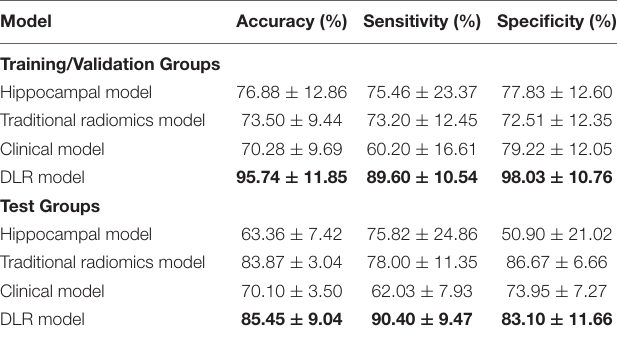
TABLE 5 | The classification results of NC vs. preAD APOE −